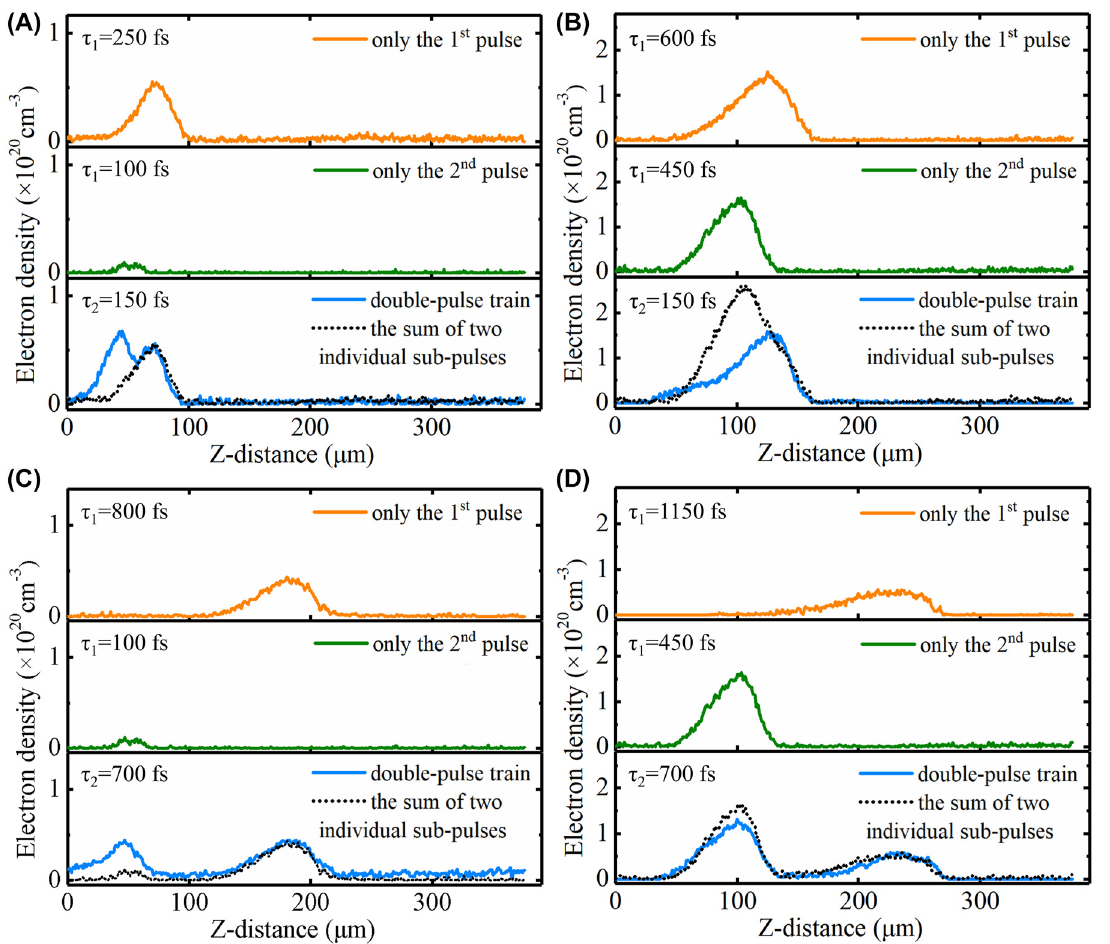
) of 100 (A, C) and 450 (B, D) fs relative to second pulse. The top panel Figure 4: Electron density evolution with pump-probe delay times ( 𝜏 1 depicts the graph obtained for irradiation with only the first pulse, the middle panel depicts the graph obtained for irradiation with only the second pulse, and the bottom panel depicts the graph obtained for irradiation with both pulses. (A, B) and (C, D) depict the cases with the ) of 150 and 700 fs, double-pulse time intervals ( 𝜏 2